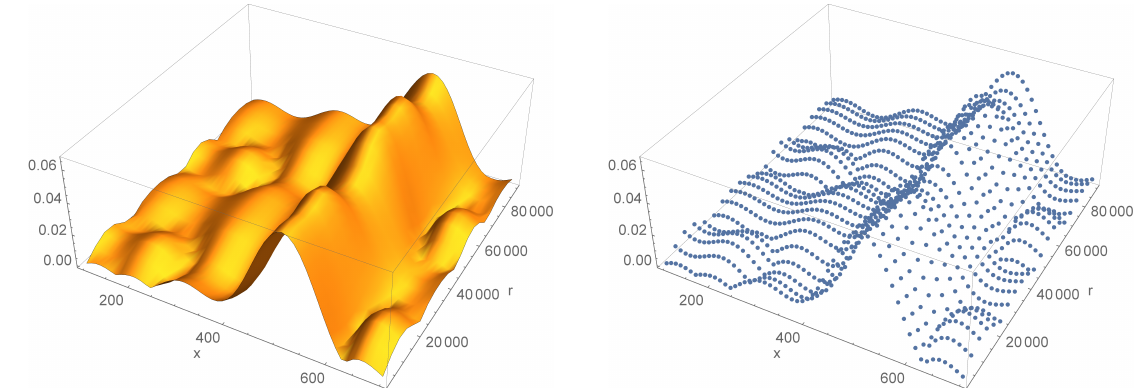
Figure 8. Reduction of the primeter data in order to avoid over-fitting. Left : reconstruction based on partial data, Right : resulting points.